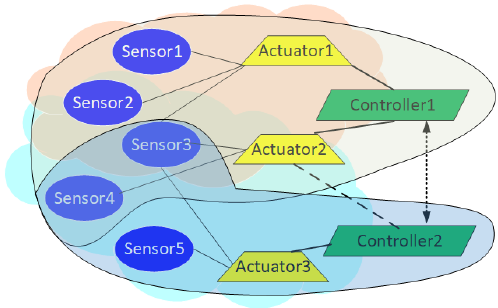
Figure 1. Internet of Things core